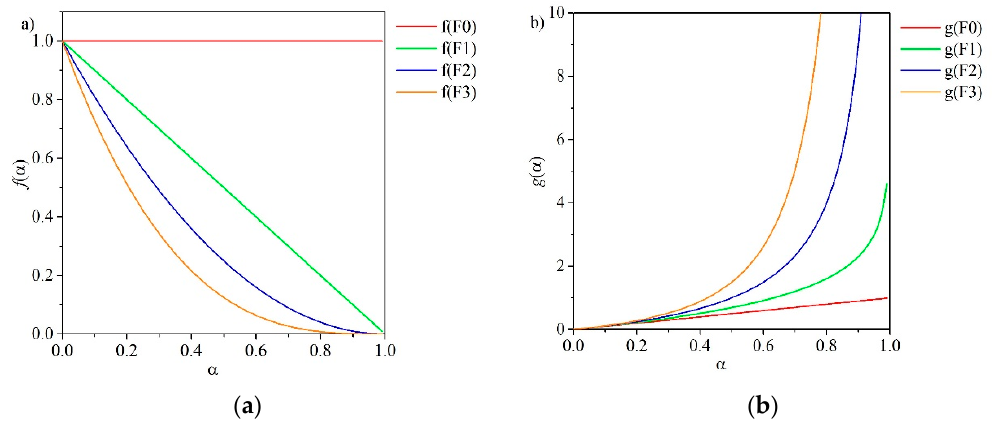
Figure 2. Order-based reaction models: ( a ) f ( α )plots; ( b ) g ( α )